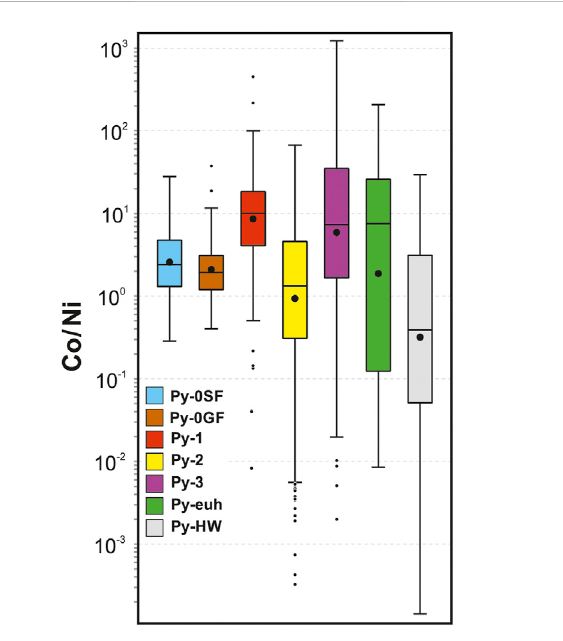
FIGURE 14 A box and whisker plot of the Co/Ni ratios for the individual pyrite sub-types. For details of the statistical method for box and whisker plots see Figure